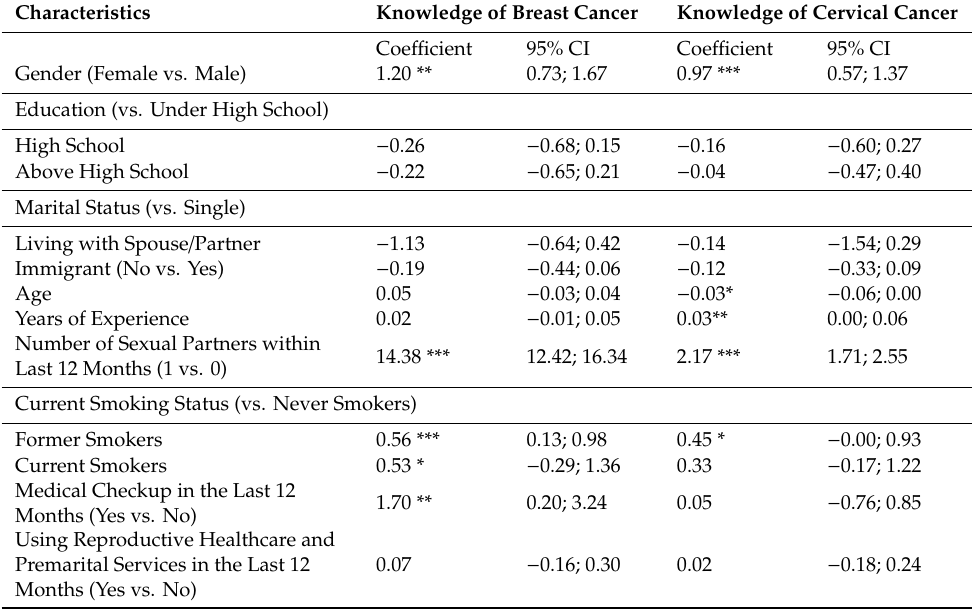
Table 5. Factors related to knowledge of breast and cervical